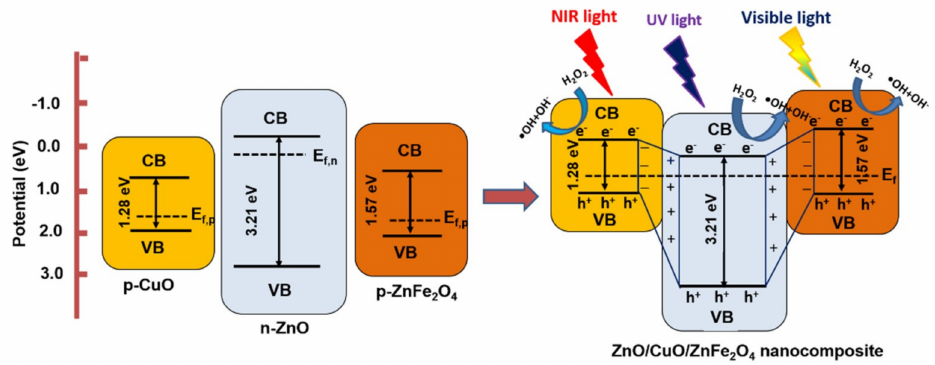
Figure 6. Schematic diagram for p-n-p heterojunction formation in the ZnO/CuO/ZnFe 2 O 4 nanocomposite and the excitation and transfer process for charge carriers in the ZnO/CuO/ZnFe 2 O 4 nanocomposite under light